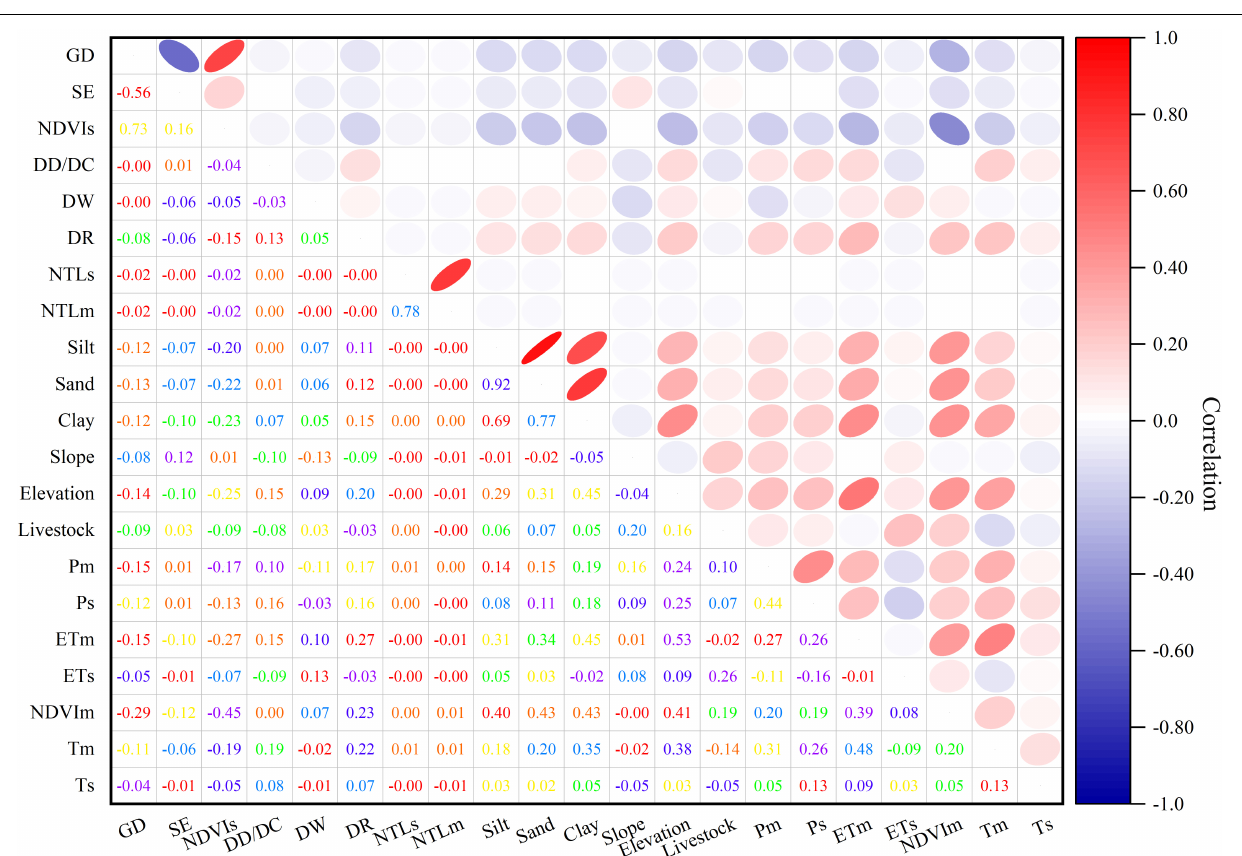
FIGURE 3 | Correlation matrix between the selected variables for grassland degradation. GD, grassland degradation; NDVIs, slope of NDVI change; SE, shrub-encroached